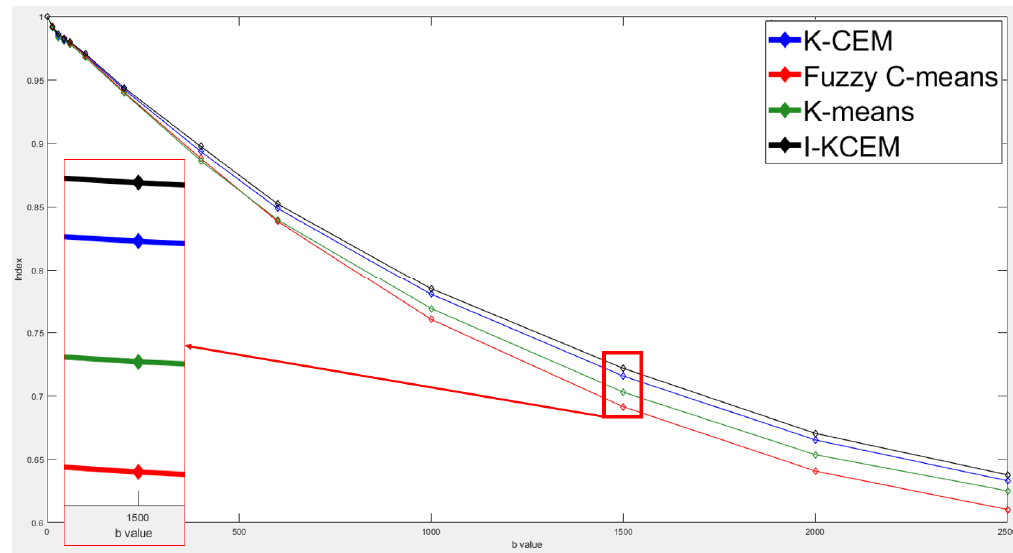
Figure 15. Eighth-slice IVIM-DW images of a cyst with b values of ( a ) 0, ( b ) 15, ( c ) 30, ( d ) 45, ( e ) 60,